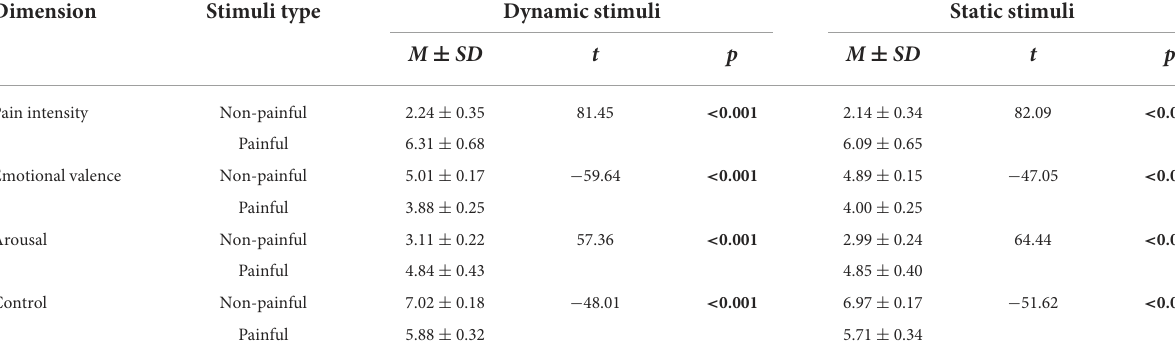
TABLE 2 The descriptive statistical analysis of dynamic and static stimuli ( M ± SD ).